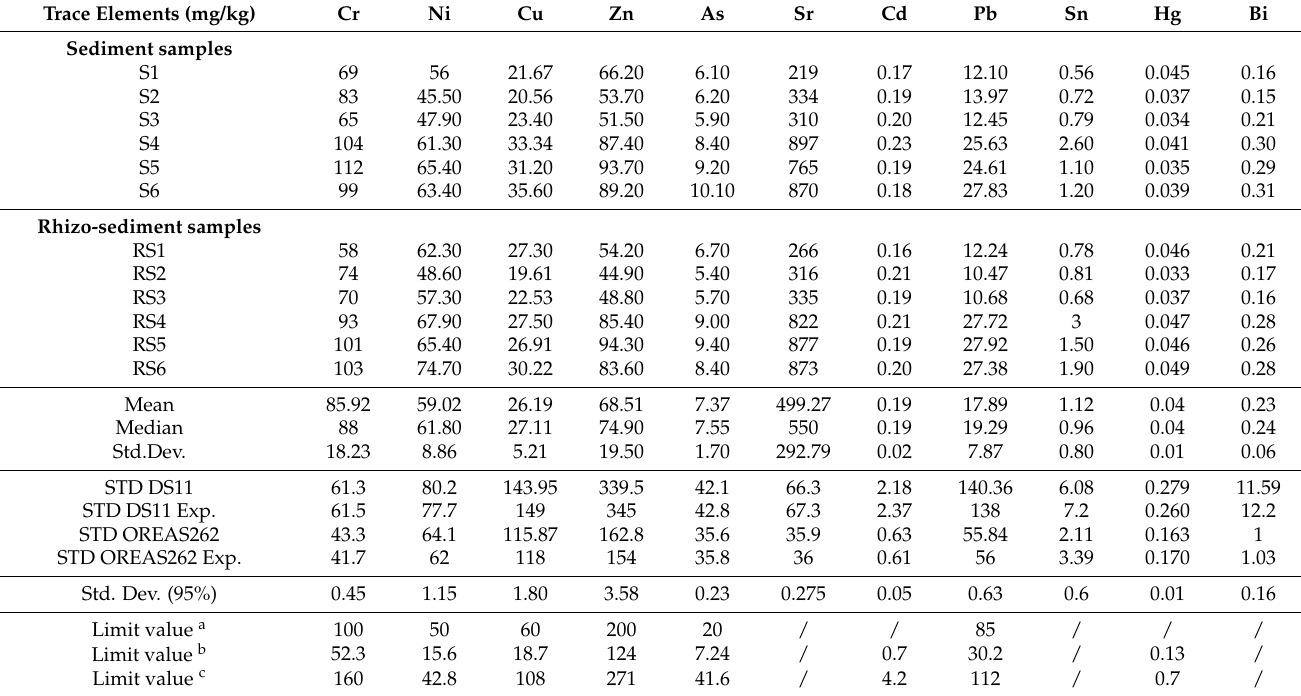
Table 5. Content ranges (mg/kg) for trace elements in the studied sediment samples, including mean, standard deviation; minimum and maximum values; standards data; critical threshold values for contaminants in soils according to Slovenian legislation a ; sediment quality guidelines threshold effect limit (TEC) b ; sediment quality guidelines probable effect limit (PEC) c